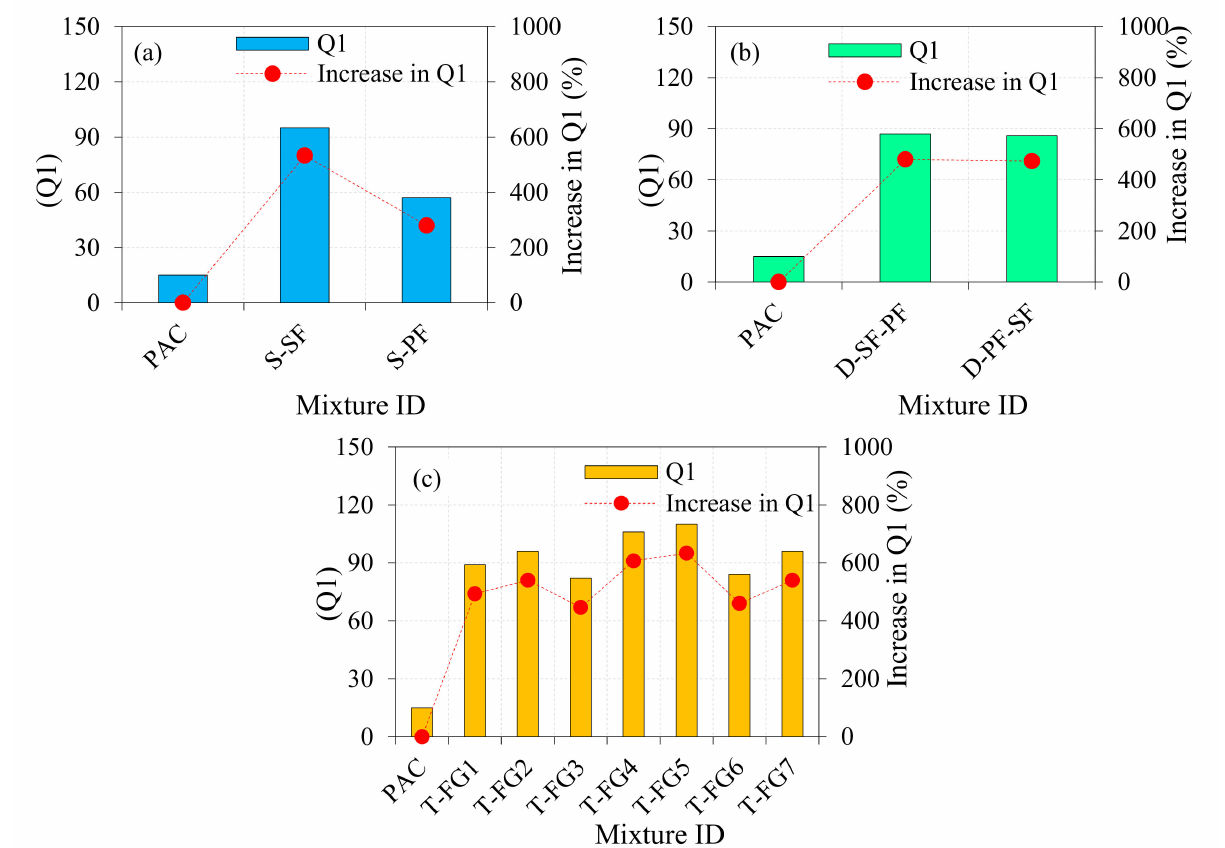
Figure 10. Cracking impact number (Q1) of the modified impact test: ( a ) single-layer specimens, ( b ) double-layer specimens, ( c ) triple-layer